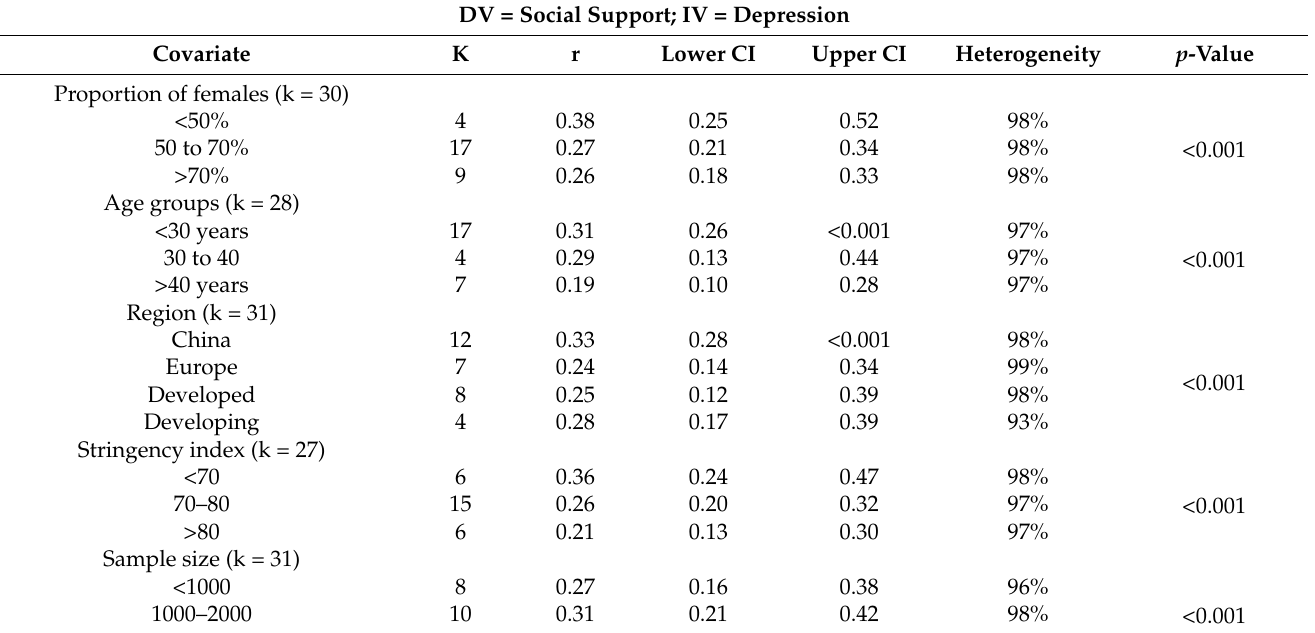
Table 3. Subgroup analysis for the associations between social support and mental disorder